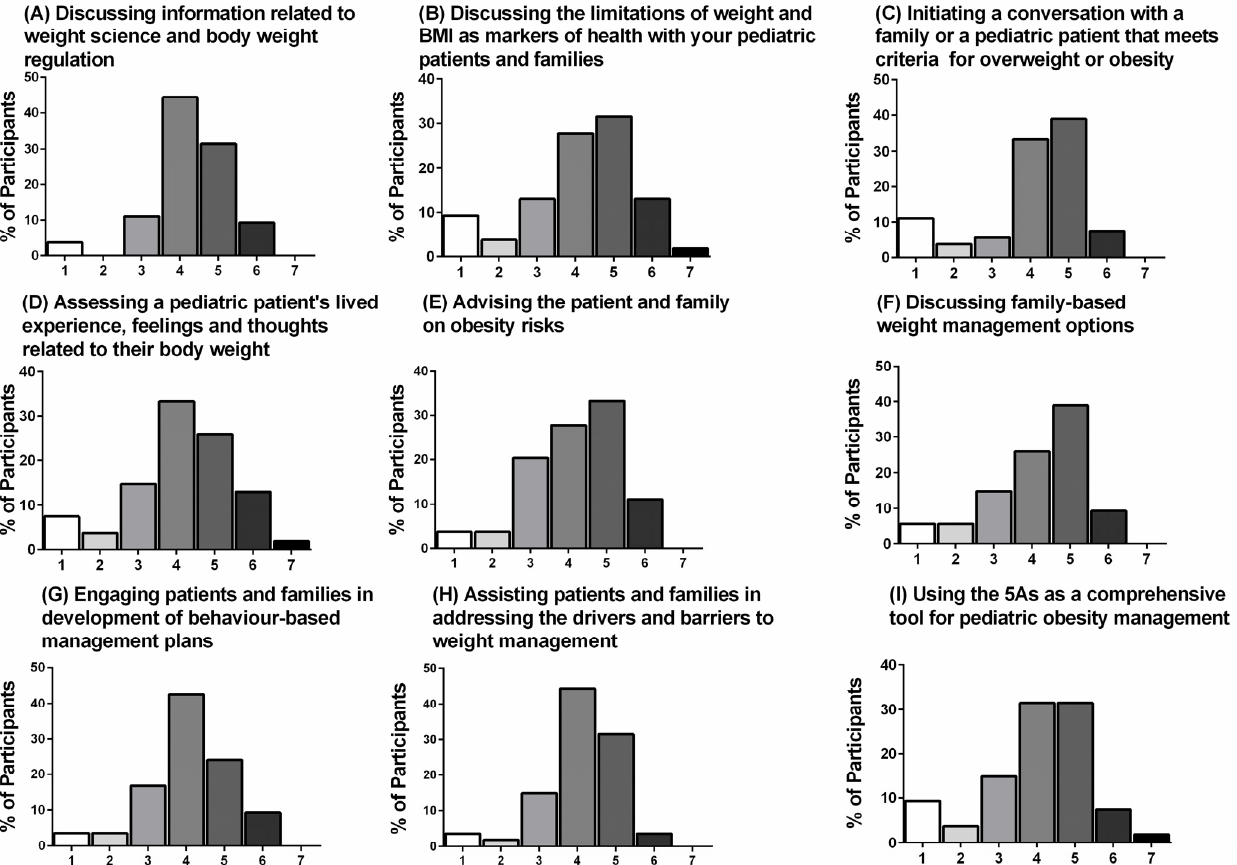
Figure 4. ( A – I ). Impact on practice 4 to 6 months later. Participant agreement (%) measured using a Likert-type scale (1 to 7, where 1 = No change, 2 = Hardly any change, 3 = No noticeable change, 4 = Somewhat changed, but the change has not made a big difference, 5 = A noticeable change, 6 = A real and worthwhile difference in my practice, and 7 = Made all the difference in my practice) is shown for each statement ( n = 54).